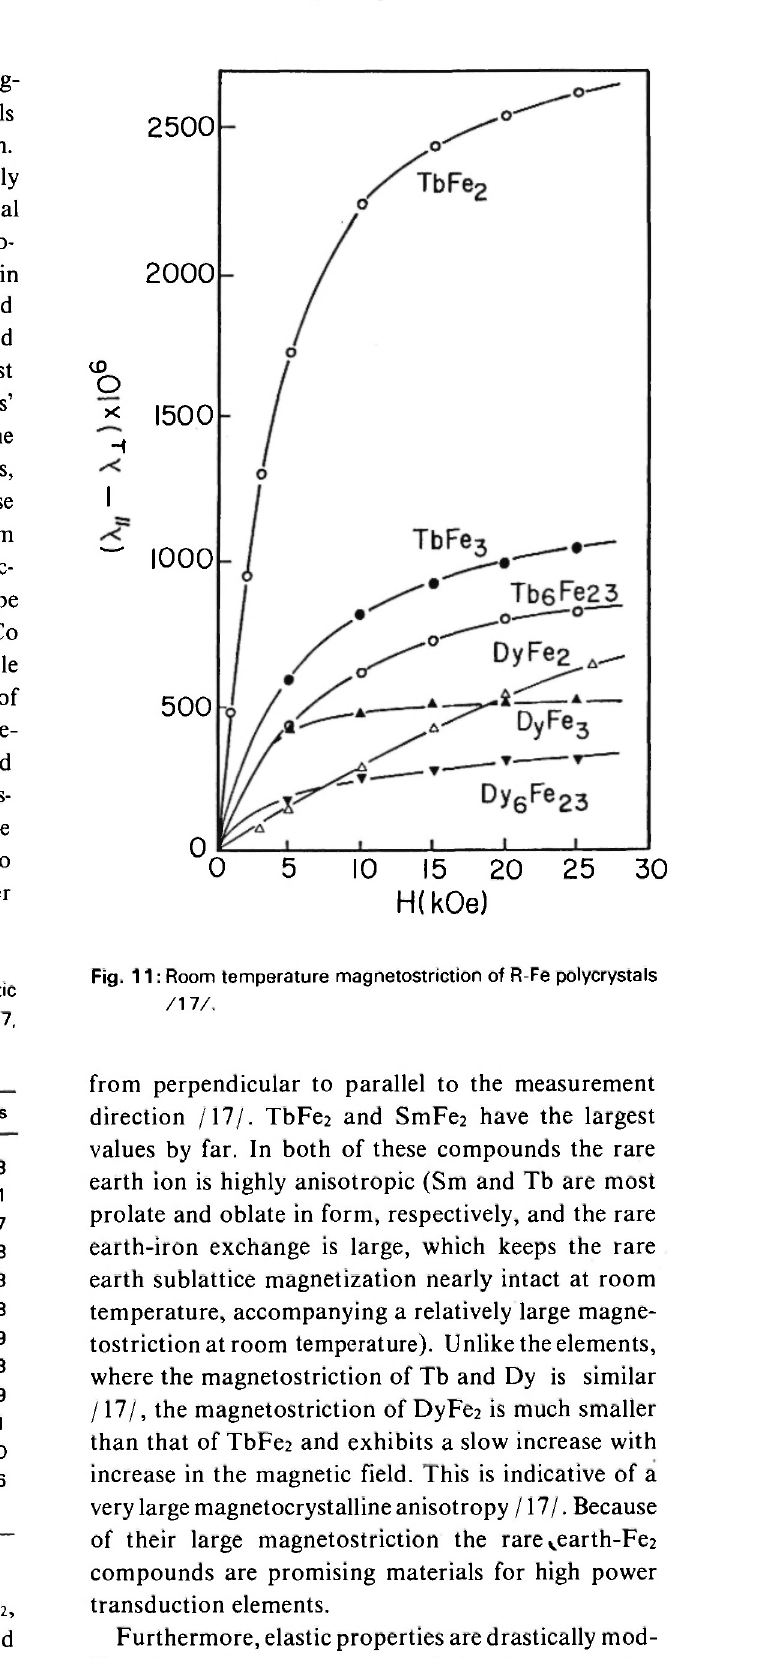
TABLE 5: Room temperature magnetostriction of ferromagnetic and ferrimagnetic metals, alloys and compounds /17, 18/.